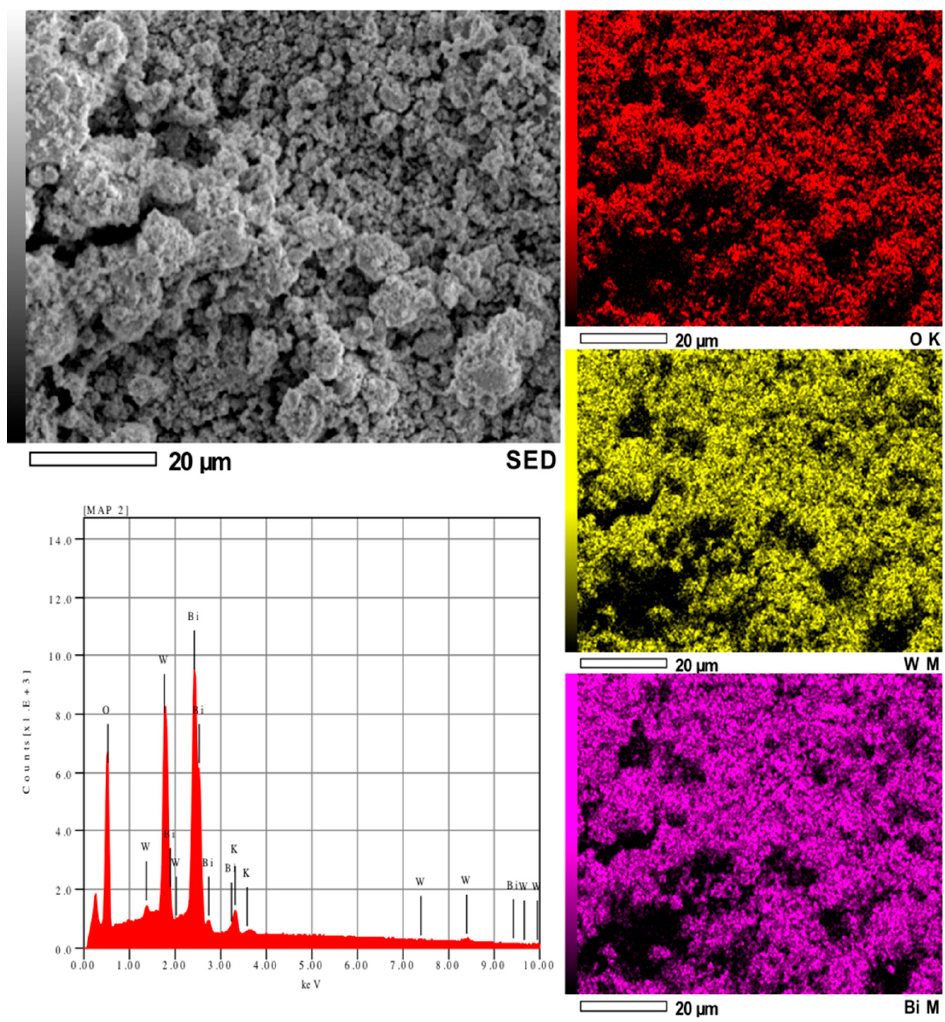
Figure 4. The corresponding EDS and the mapping of the O, W, and Bi elements (BWO-600), respec- tively.